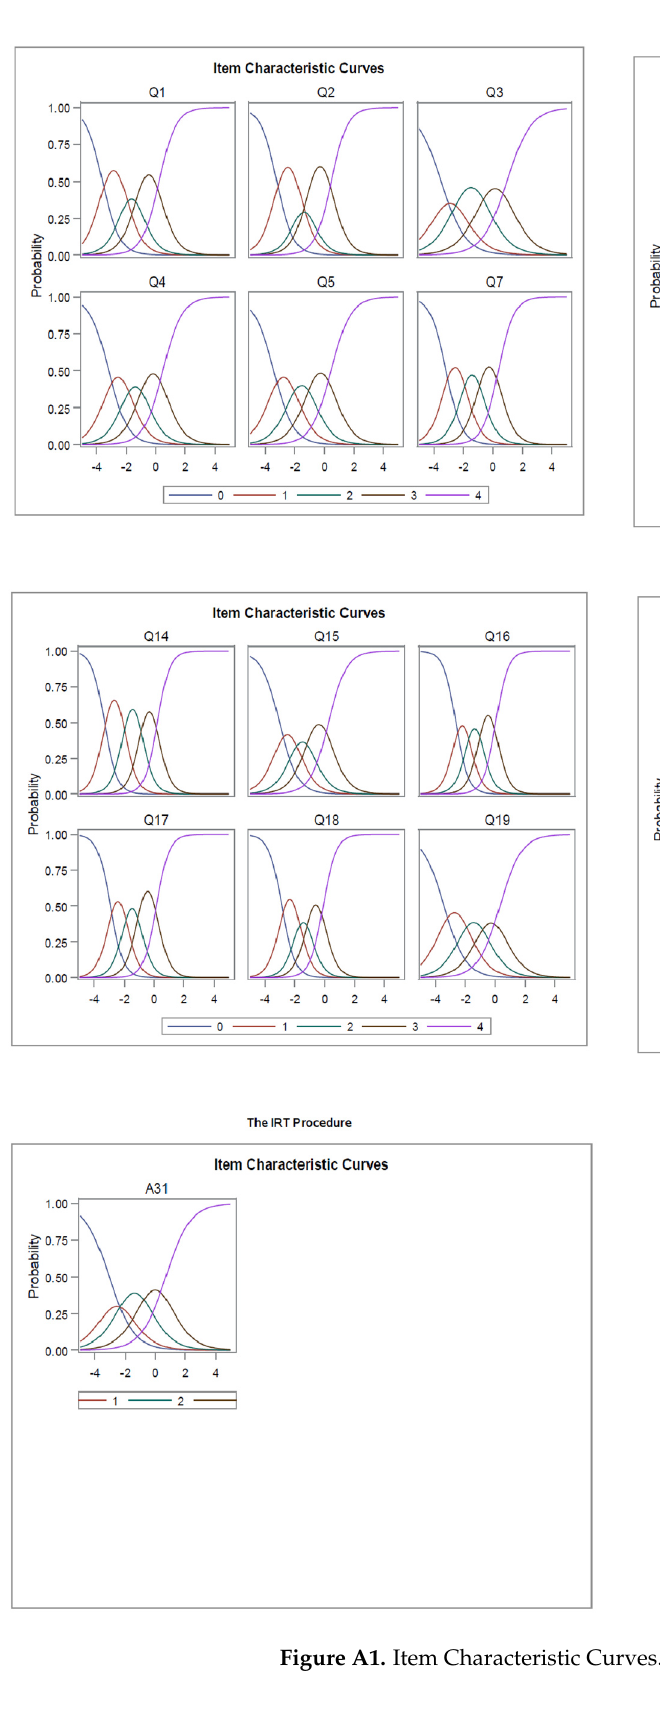
Figure A1. Item Characteristic Curves.